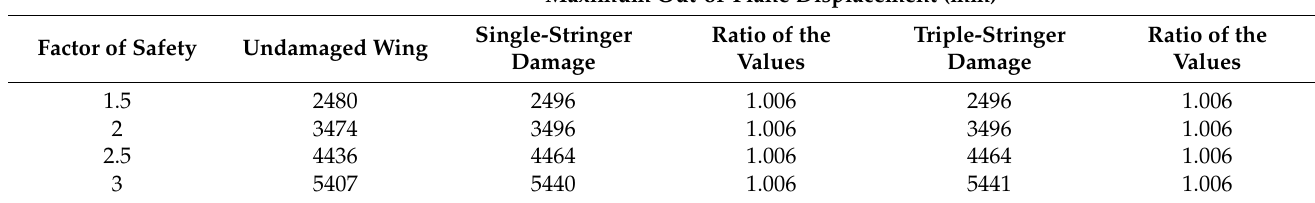
Table 9. Comparison of out-of-plane displacement in the undamaged wing and wing containing stringer damage.